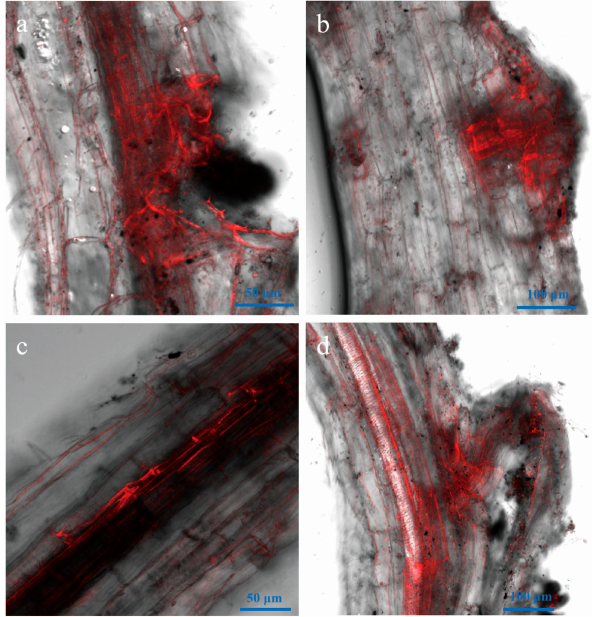
Figure 5. LSCM of hyphal colonization of root vessels from four to six dpi. ( a , b ) four dpi; ( c , d ) five and six